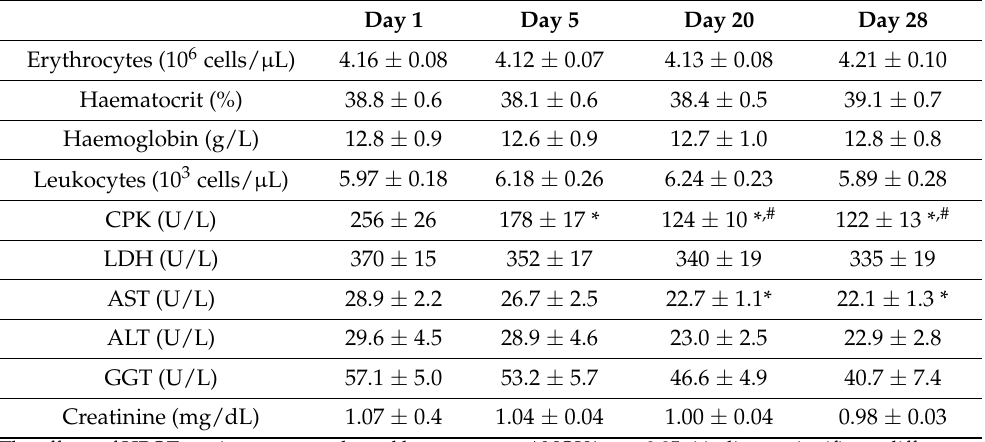
Table 1. Haematological and serum biochemical parameters before sessions of the HBOT, 1, 5, 20 and 28 (days) after wound